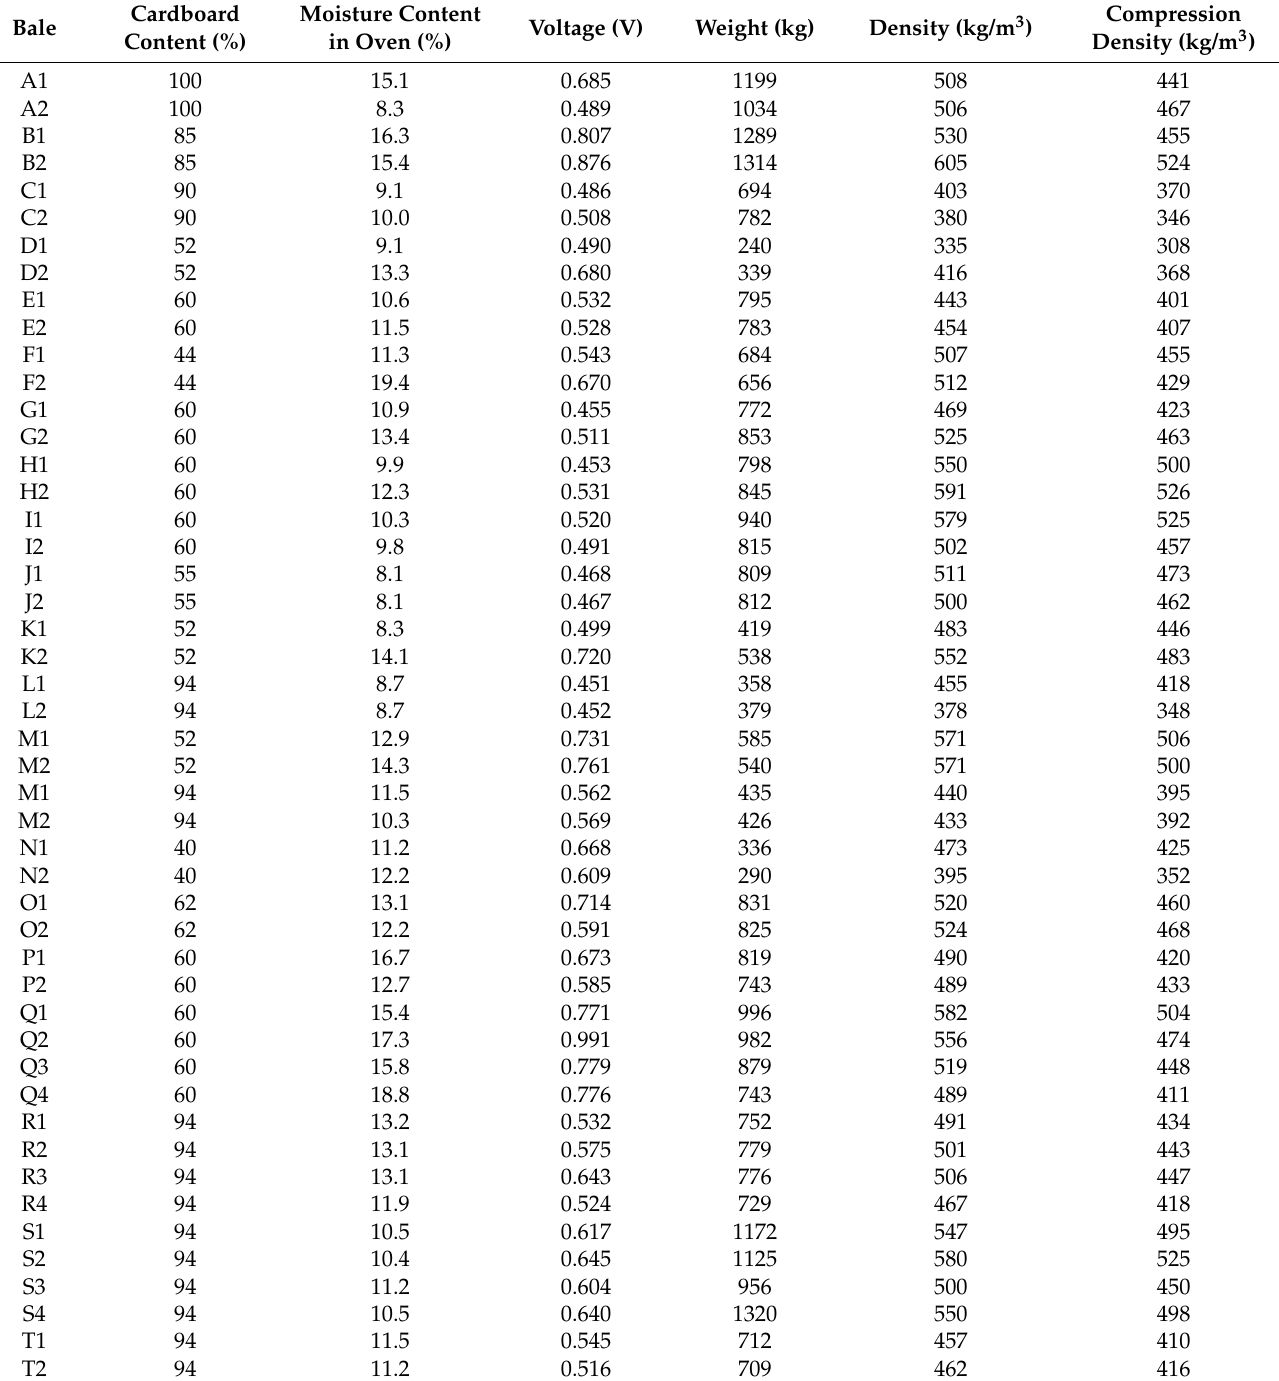
Table 2. Characteristics of the 48 analyzed